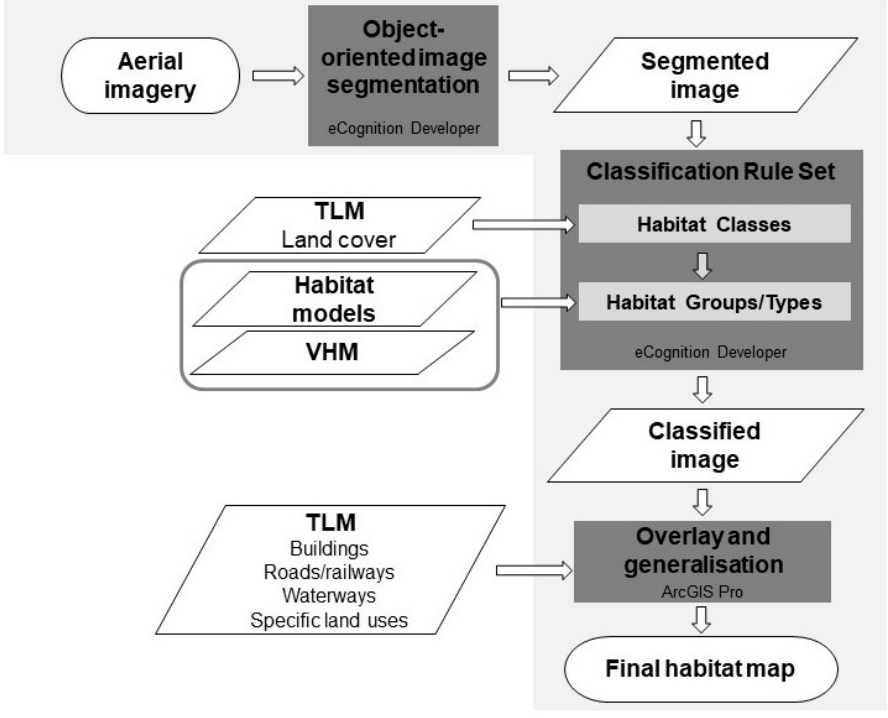
Figure 1. Workflow for the development of the Habitat Map of Switzerland. Aerial imagery is segmented within the eCognition Developer software, and image segments are classified into habitat types informed by habitat and species distribution models, the vegetation height model (VHM) and topographic landscape model (TLM) land cover data. The classified images are exported in vector format and overlaid with small-scale features from the TLM, generalised and merged in ArcGIS to form the final habitat map.